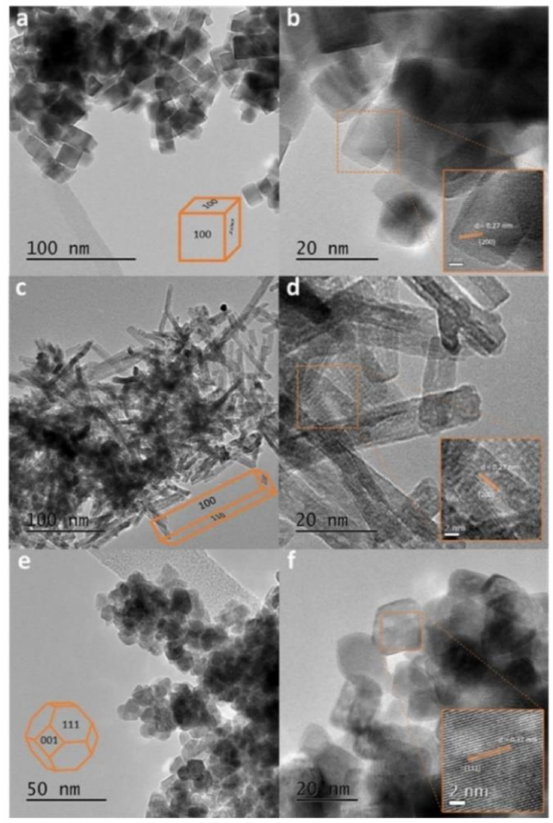
Figure 2. Transmission electron microscopy (TEM) images of ceria nanoparticles (NPs) with different morphologies: ( a , b ) cubic, ( c , d ) rodlike, and ( e , f ) polyhedral. Reproduced from